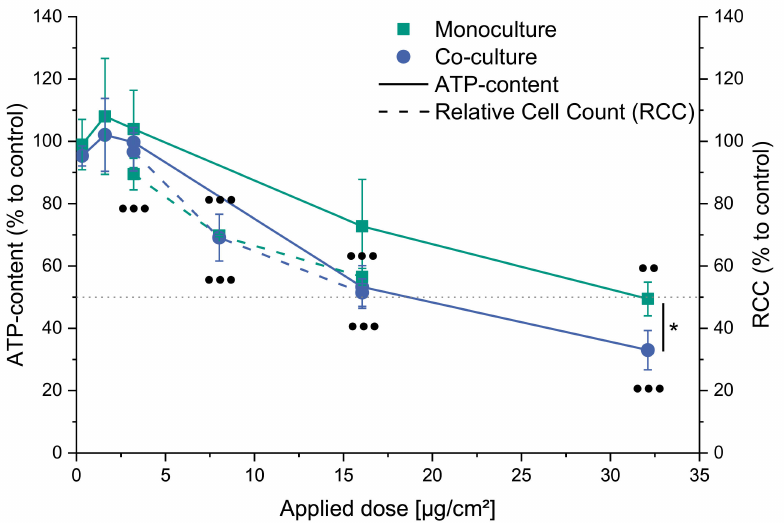
Figure 2. Impact of CuO NP on the ATP-content and relative cell count (RCC) of a mono- (A549) and co-culture (A549 + dTHP-1). Monocultures are displayed in green squares and co-culture in blue circles. ATP-content is shown as a solid line, and RCC is plotted as a dashed line. Shown are the mean values of three independent experiments ± standard deviation (SD). Statistics were performed using either t -test (* ≤ 0.05) to compare differences between mono- and co-culture or ANOVA-Dunnet’s t -test ( • ≤ 0.05, •• ≤ 0.01, ••• ≤ 0.001) to compare differences between doses of one